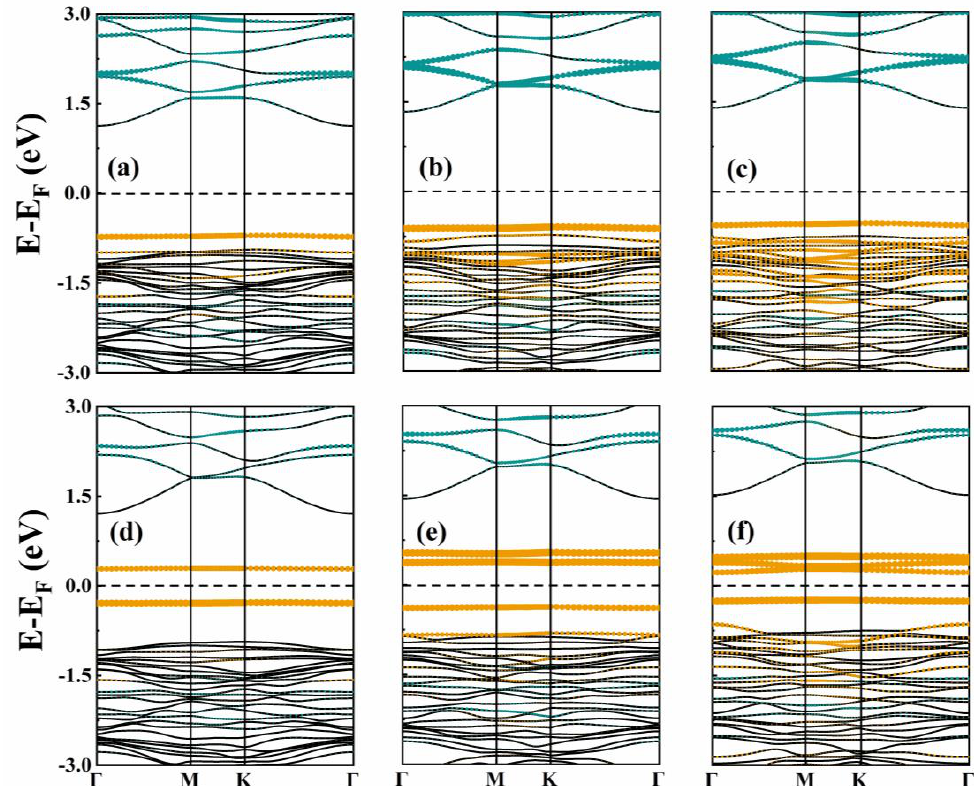
Figure 3. The spin-up band structures of ( a ) Ga 14 N 15 Gd 2 C 1 , ( b ) Ga 14 N 14 Gd 2 C 2 and ( c ) Ga 14 N 13 Gd 2 C 3 monolayers. The spin-down channels of ( d ) Ga 14 N 15 Gd 2 C 1 , ( e ) Ga 14 N 14 Gd 2 C 2 and ( f ) Ga 14 N 13 Gd 2 C 3 monolayers. The green and orange dotted lines represent the energy levels of Gd and C atoms, respectively. The dashed lines represent the Fermi level, which is taken to be 0. Table 2. Magnetic moments ( μ B ), energy difference ( ∆E = E AFM − E FM , meV), nearest-neighboring